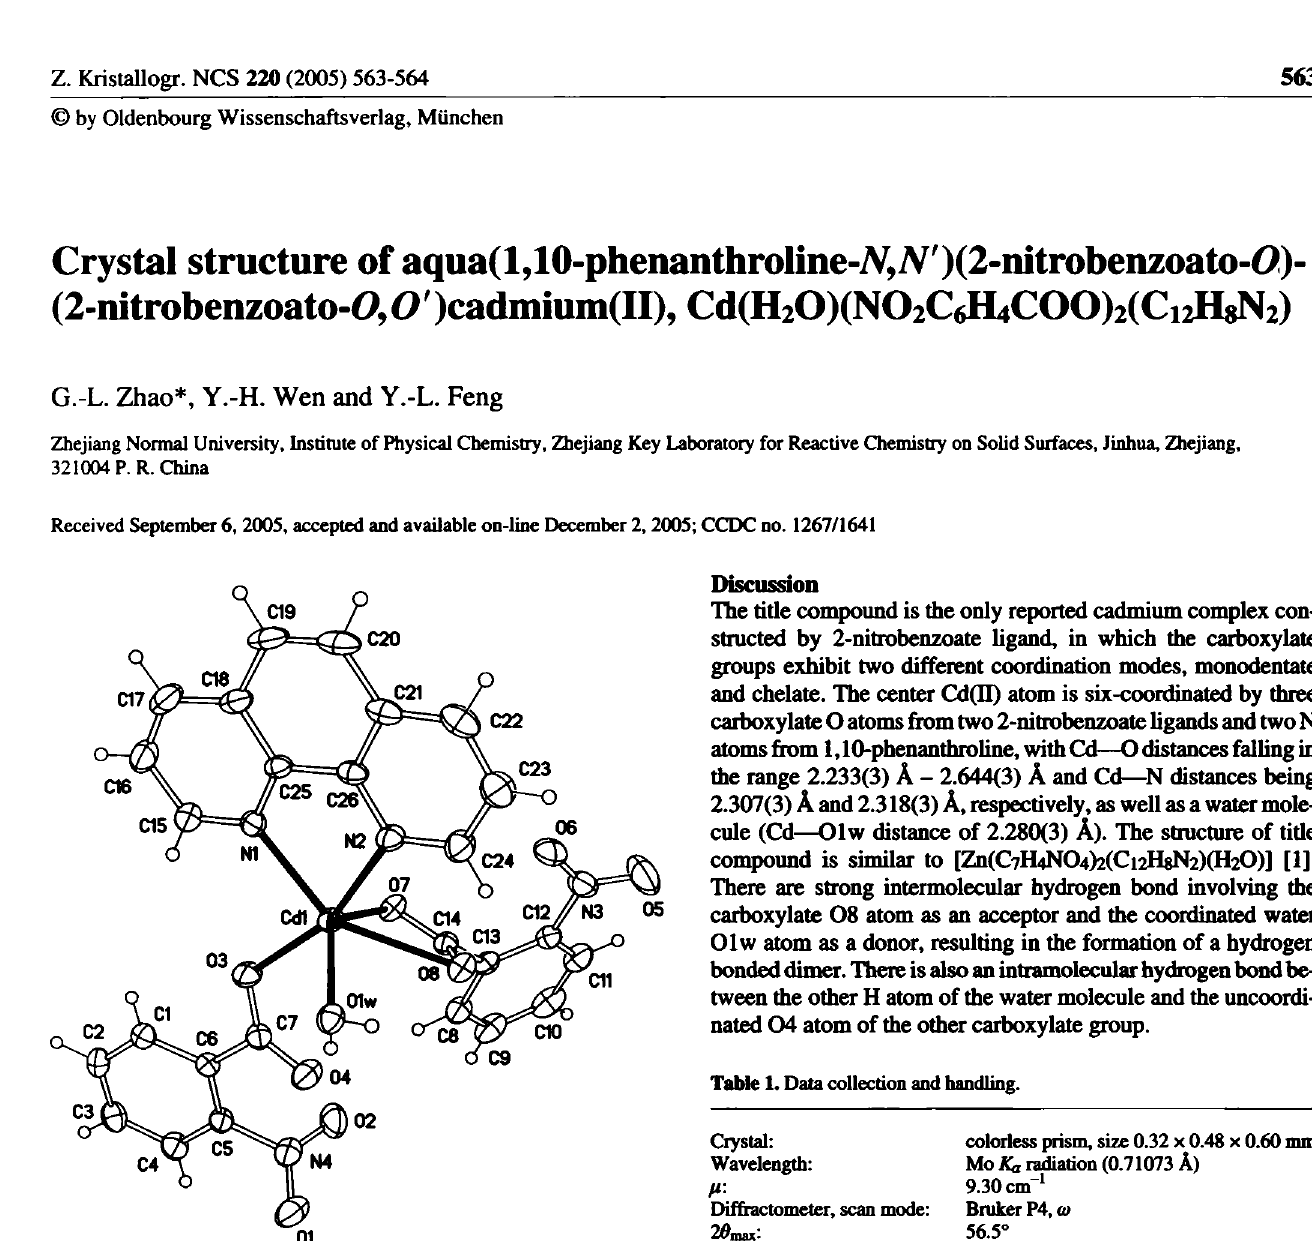
Table 1. Data collection and handling.